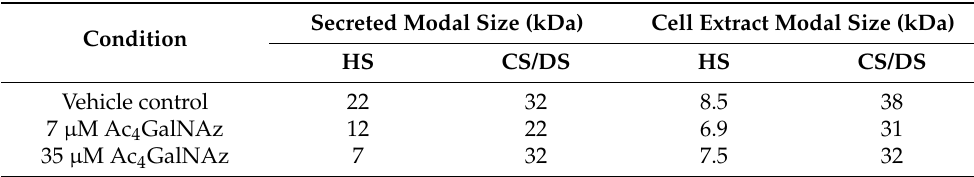
Figure 4. Total GAG synthesis normalised to protein levels from CHO-K1 cells. Table 1. Chain length of radiolabelled HS and CS/DS.